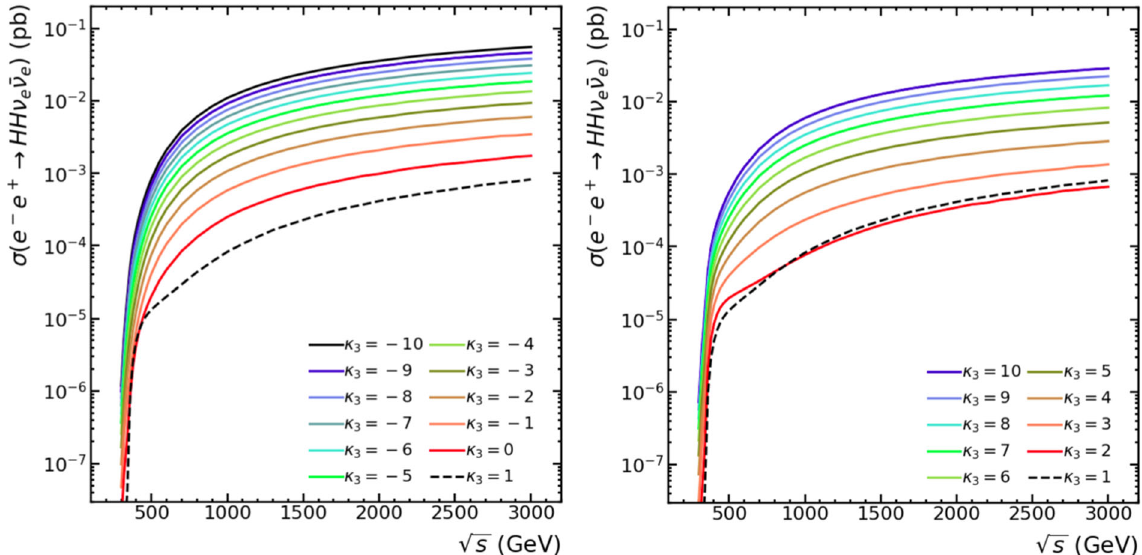
√ s for different values of the parameter κ 3 , with κ 4 set to 1,